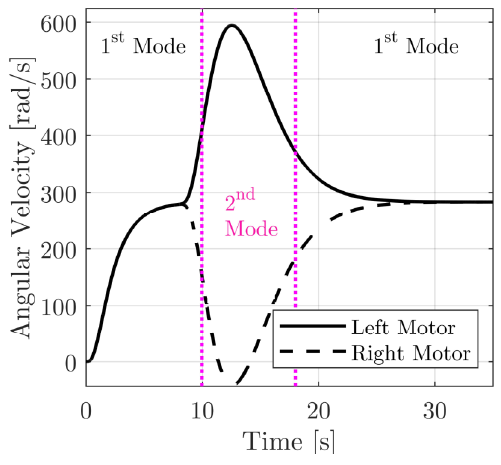
Figure 5. Motor currents.